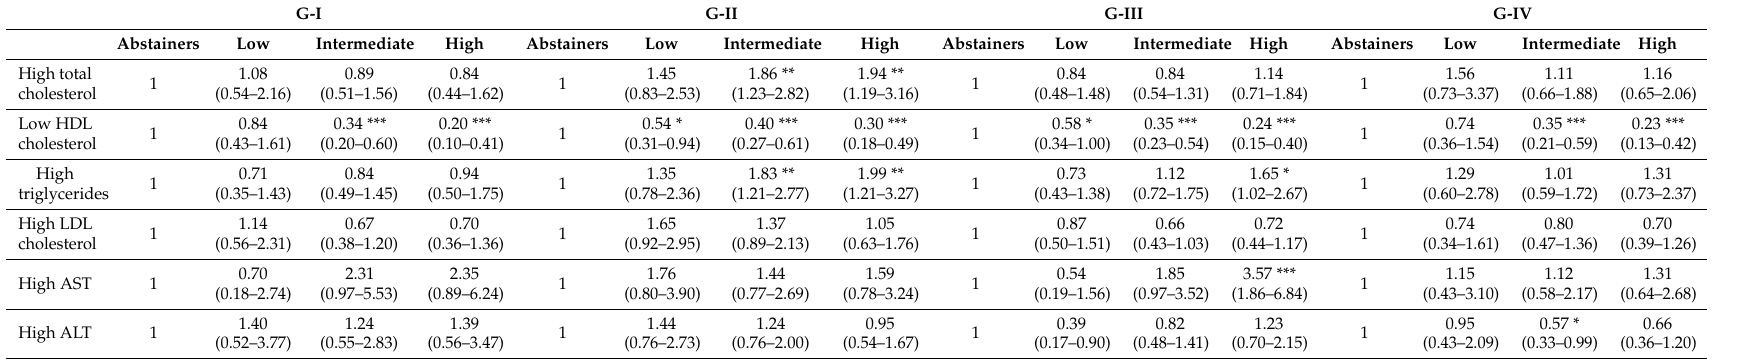
Table 5. Metabolic risk factors by alcohol consumption and β -cell function and insulin sensitivity in